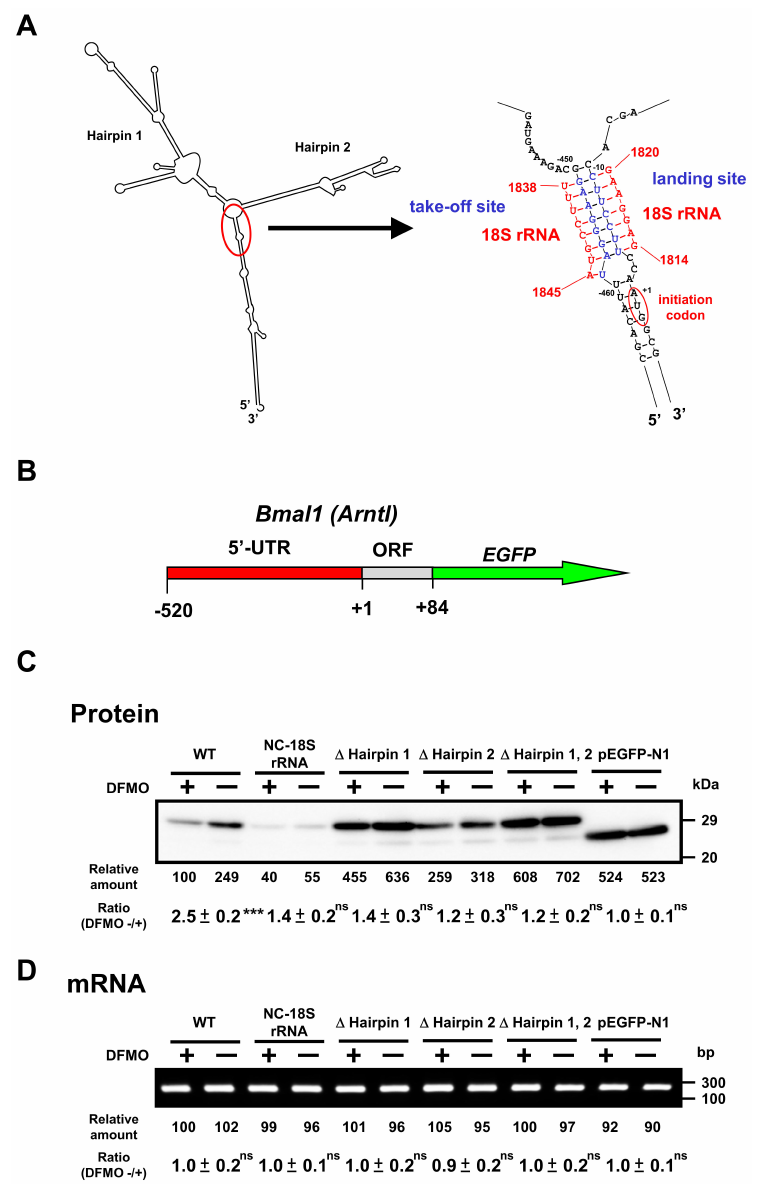
Figure 5. Effect of polyamines on the synthesis of BMAL1-enhanced green fluorescent protein (EGFP) derived from normal and modified Bmal1-EGFP mRNAs in NIH3T3 cells. ( A ) Optimal computer folding of the 5 (cid:48) untranslated region (UTR) of Bmal1 mRNA was performed by the method of Zuker [26]. Candidates for take-off and landing sites, which are complementary sequence to 18S rRNA are shown in blue, together with the sequence of 18S rRNA in red. ( B ) Structures of Bmal1-EGFP fusion genes are shown. ( C , D ) The levels of protein and mRNA were measured by Western blotting and RT-PCR, respectively, after transient transfection of Bmal1-EGFP fusion gene encoding normal and modified 5 (cid:48) -UTR of Bmal1 mRNA, 28 amino acids of the amino terminal end of BMAL1 protein, and full length of EGFP protein. As a control, Western blotting and RT-PCR for EGFP were performed. ns p ≥ 0.05; *** p <